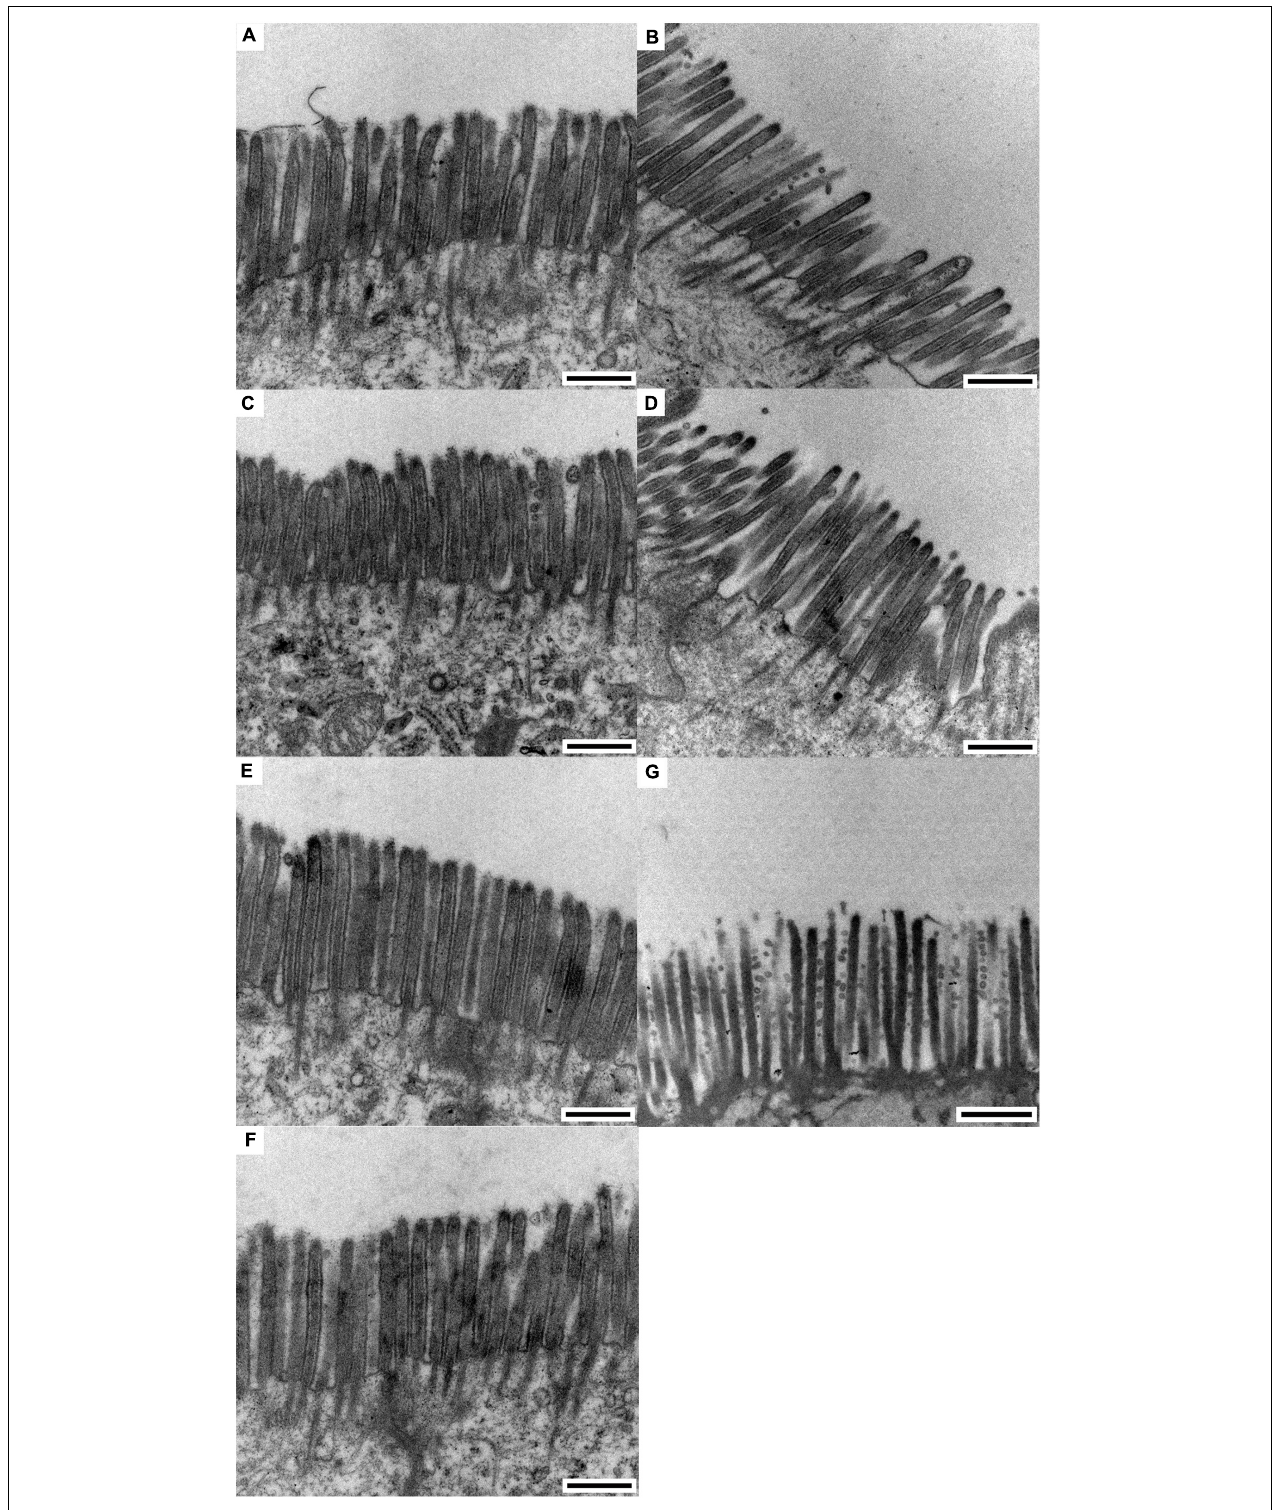
FIGURE 3 | Transmission electron microscopy of the small intestine of weaned piglets (0.5 µ m). (A–G) indicate the CON, ANT, ZO, NZO, LPNZ, MPNZ, and HPNZ groups, respectively. (A–G) show the appearance of the microvilli under a transmission electron microscope. Unit length 0.5 µ m. The microvilli in the small intestine of CON, ANT, ZO, NZO, and HPNZ are damaged and differ in length (A–D,G) . In contrast, the microvilli of the LPNZ and MPNZ are arranged neatly, with uniform thickness and density (E,F) .